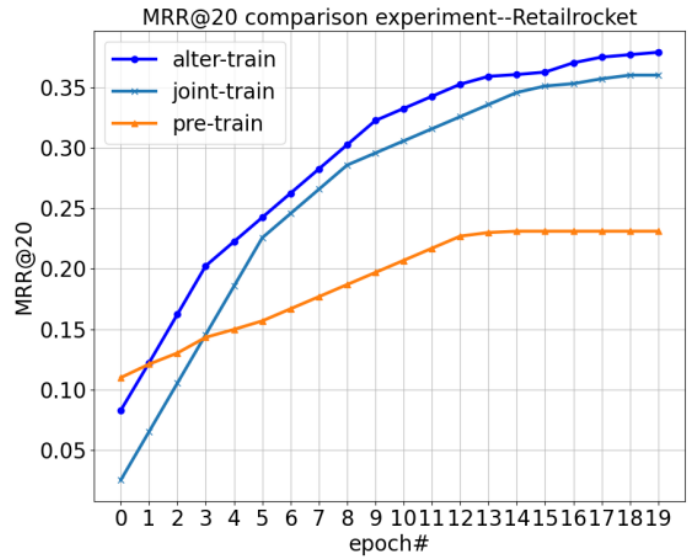
Figure 10. MRR@ 20 curve change chart—Retailrocket.